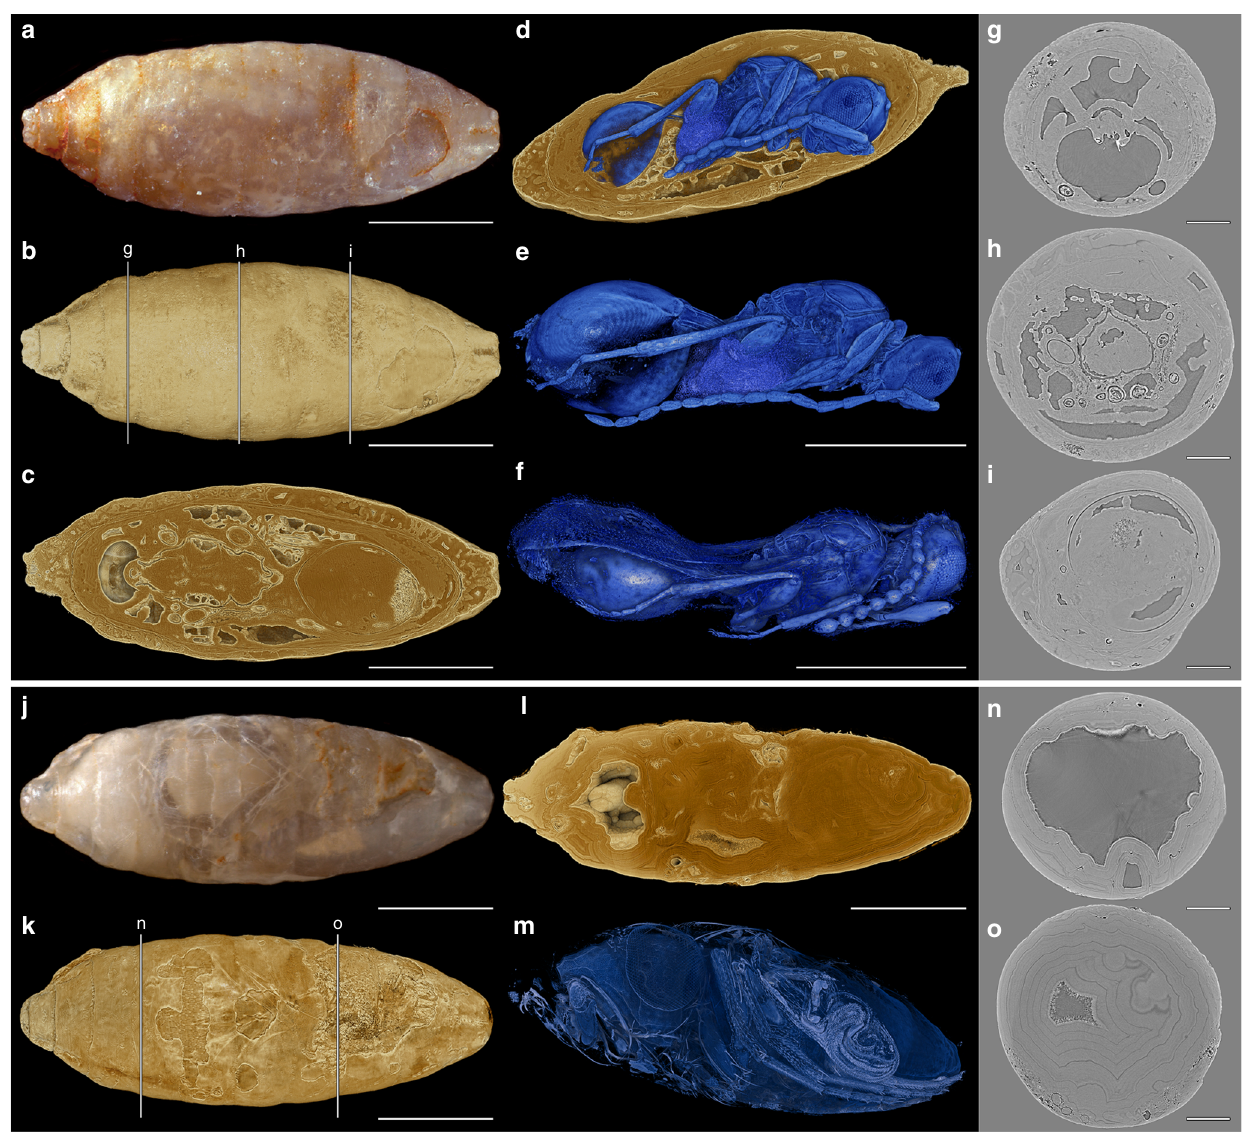
Fig. 1 X-ray tomography of fossils. a Host fl y puparium (NRM-PZ Ar65720). b Volume rendering of a . c Longitudinal section of b . d Parasitoid wasp inside host (perspective view; Supplementary Movie 1). e Xenomorphia resurrecta , male (NRM-PZ Ar65720) in symmetric posture with folded wings. f X. resurrecta , female (NMB F2875) in asymmetric posture with unfolded wings. g – i Transverse sections of tomogram as indicated in b . j Host fl y puparium (NRM-PZ Ar65810). k Volume rendering of j . l Longitudinal section of k . m Volume rendering of host fl y (perspective view). n – o Transverse sections of tomogram as indicated in k . Scale bars: a – c , e , f , j – l = 1 mm; g – i , n , o = 250 µ